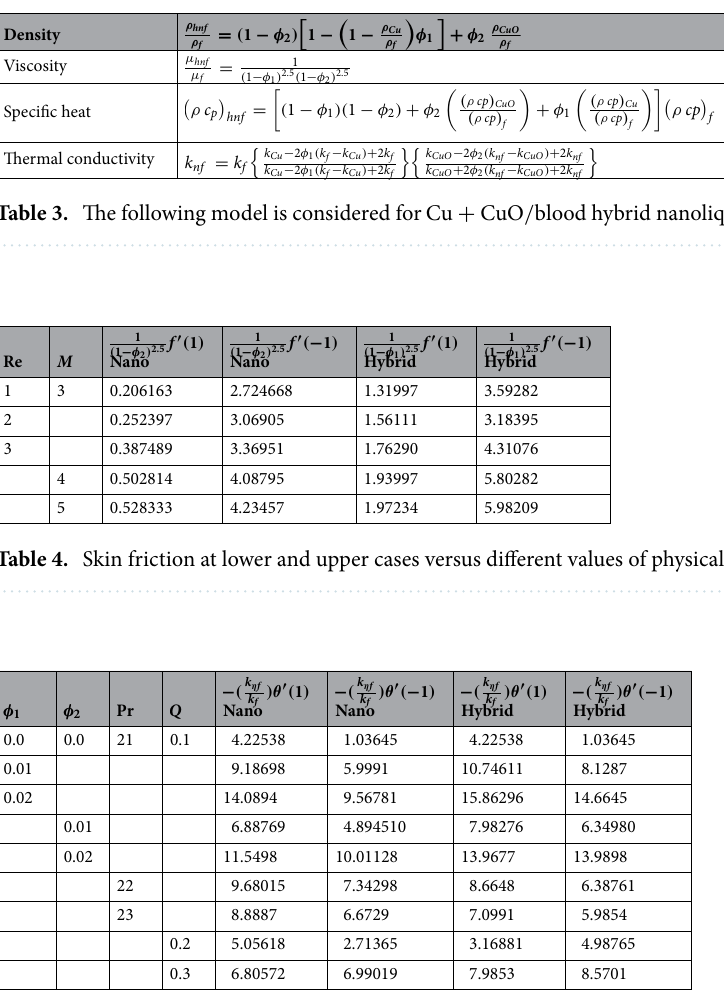
Table 5. Nusselt number for lower and upper case versus different values of physical constraints .